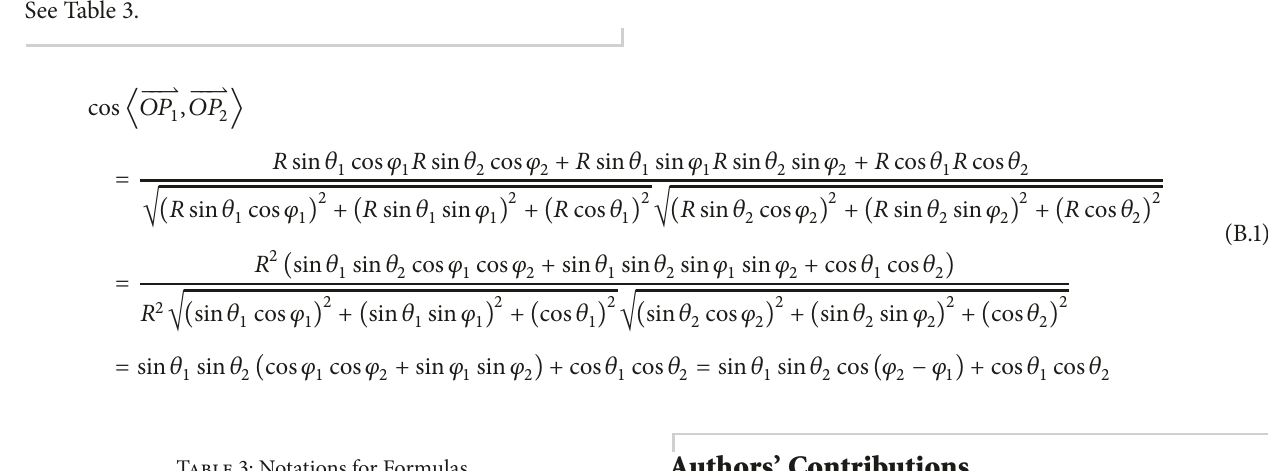
Table 3: Notations for